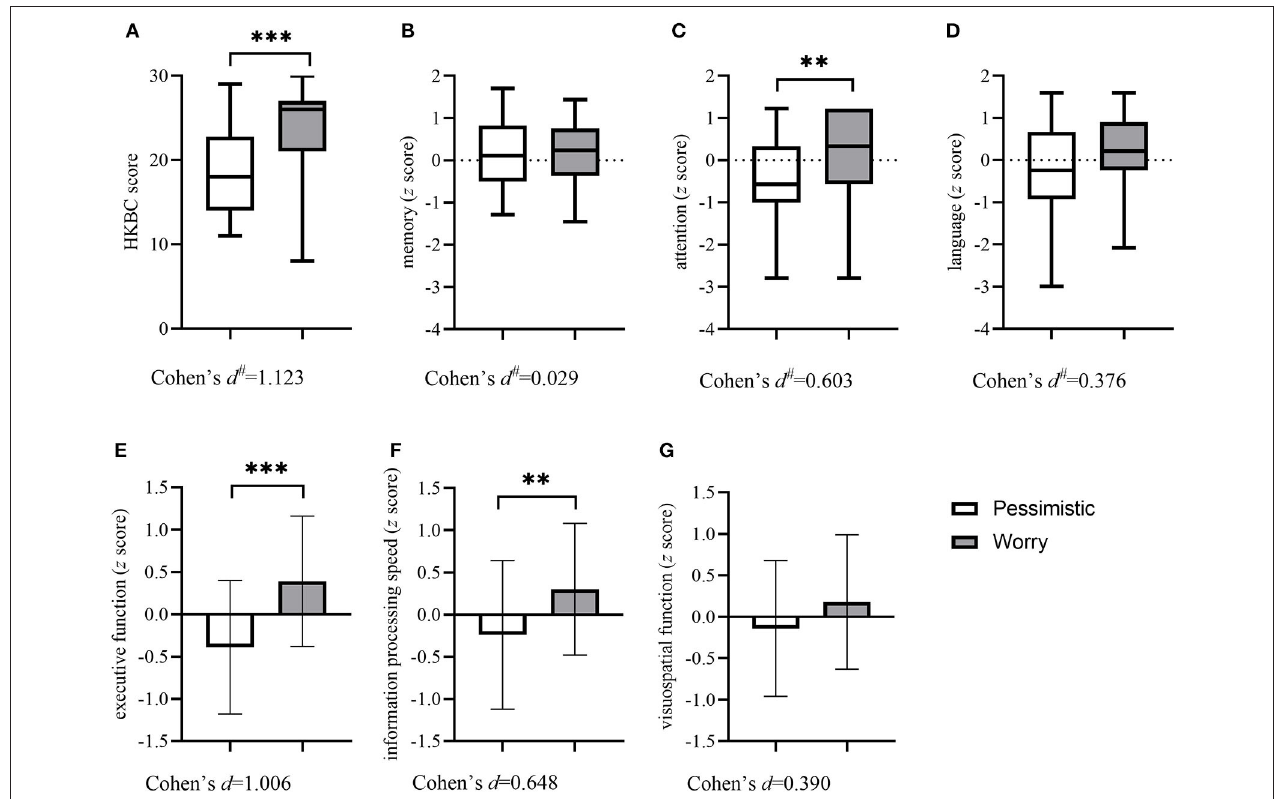
FIGURE 2 | Comparisons of the HKBC test and six cognitive domains between groups. Column (with errors) and box (with min and max) plots show the differences in general cognitive function and six cognitive domains between the two groups. (A) HKBC; (B) Memory; (C) Attention; (D) Language; (E) Executive function; (F)